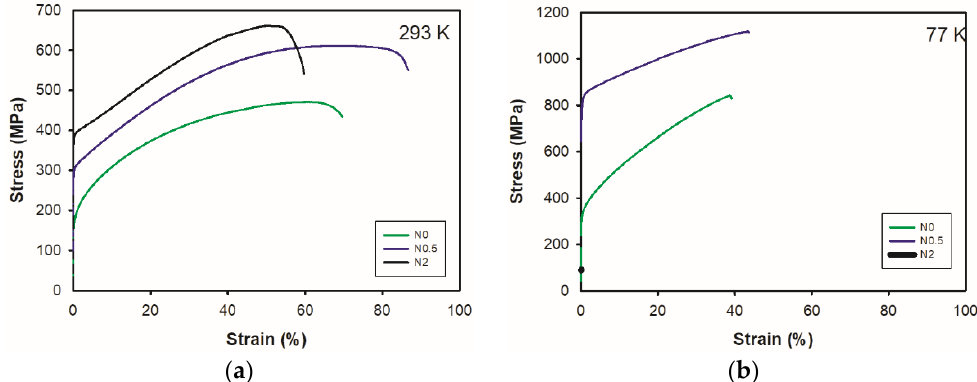
Figure 2. Stress–strain curves of the as-cast Fe 40-x Mn 40 Cr 10 Co 10 N x alloys obtained during tensile testing at room ( a ) and cryogenic ( b ) temperatures. Table 2. Room and cryogenic temperature mechanical properties of the Fe 40-x Mn 40 Cr 10 Co 10 N x alloys.